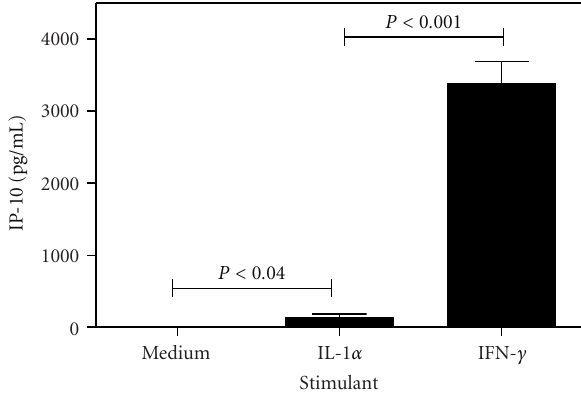
Figure 5: Cultured fibroblast cells produce IP-10 in response to stimulation with proinflammatory mediators. 4 × 10 4 cultured mouse corneal fibroblast cells were incubated at 37 ◦ C and 5% CO 2 in 500 μ L serum-free media with or without cytokine stimulation for 24 h. Cells were stimulated with 10 ng/mL of either recombinant mouse IL- α or IFN- γ and assayed for IP-10 production by